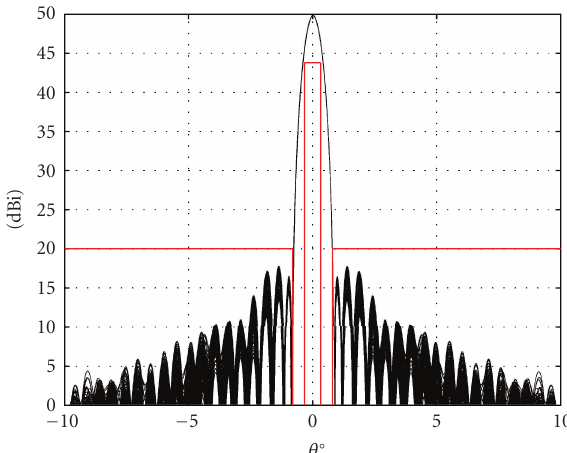
Figure 7: Array pattern for the configuration depicted in Figure 6. The beam is scanned to boresight. The red line corresponds to the requirement mask.